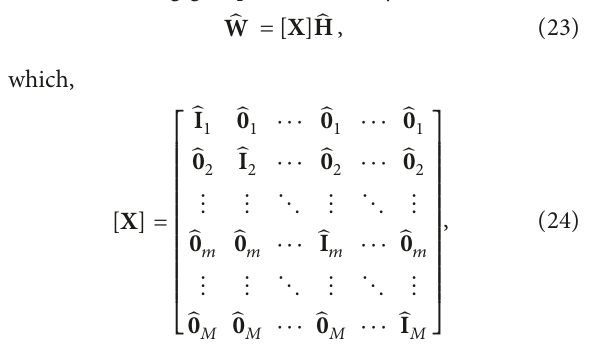
Table 2: The convergence of the vertical impedance of a single strip footing.